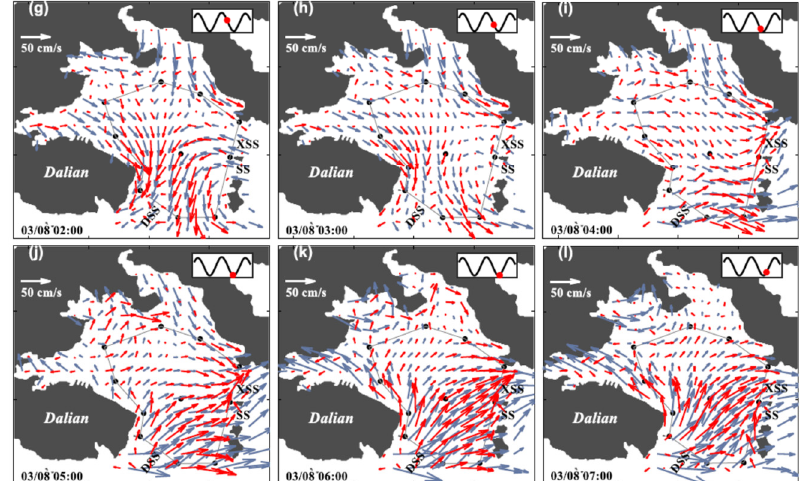
Figure 6. Hourly mapping ( a – l ) of the hourly-mean horizontal current fields calculated using the CFM (red arrows) and NCM (gray arrows). The observation time and the corresponding sea level height (red dot) are indicated in the lower-left and upper-right corners, respectively.